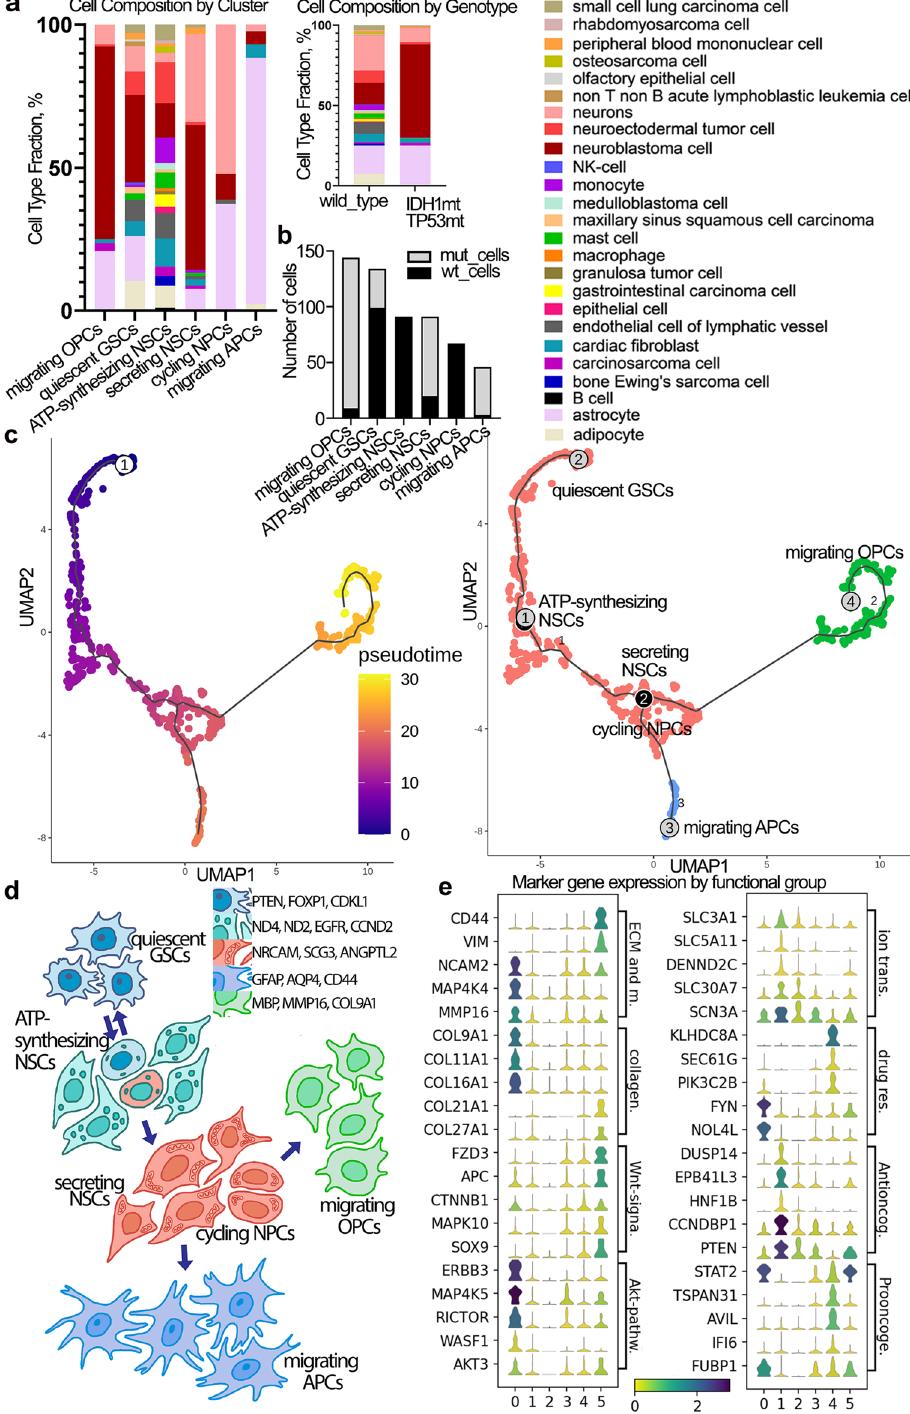
Figure 3. Characterization of the cell cluster features. ( A ) Cell types in % of total cell number assigned to Seurat clusters (left big) and wt- and mt-samples (right small) by scMatch. Color panel describes the assigned cell types (B) Number of wt- (black) and mt- (grey) cells per cluster ( C ) Seurat clusters ordered in accordance with the RNA velocity (the first derivative of newly transcribed RNA and mature RNA) – a differentiation pseudotime by Monocle3. Colored by pseudotime—the shortest distance between a cell and the start of the trajectory (left) and by Seurat clusters (right). ( D ) Model for the GSC hierarchy annotating cell types, their genetic and morphological determinants. Red color indicates cycling cells. ATP-synthesizing NSCs and cycling NPCs have the same color annotating the prevalence of proliferation program in both subpopulations. Left upper panel describes prominent markers for each differentiation step. ( E ) Stack violin plots highlighting marker gene expression grouped as ECM and migration (ECM and m.), collagens (collagen.), Wnt-signalling (Wnt-signa.), Akt-pathway (Akt-pathw.), ion transport (ion trans.), drug resistance (drug res.), antioncogenes (antioncog.), prooncogenes (prooncoge.). Genes grouped by cell annotations (side description) and UMAP clusters (down column bar: 0 – “migrating OPCs”, 1 – “quiescent GSCs”, 2 – “ATP-synthesizing NSCs”, 3 – “secreting NSCs”, 4 – “cycling NPCs”, 5 – “migrating APCs”). The violin shape displays the number of the cells expressing a gene, the continuous color panel defines median expression value of a gene from the absence of expression (yellow) to high expression (dark